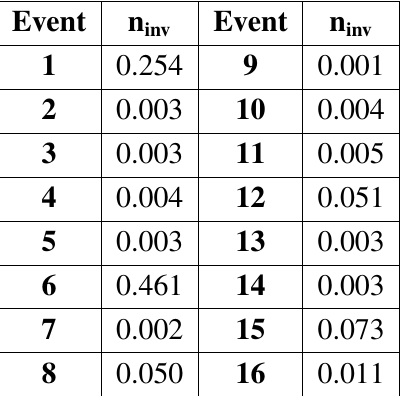
Table 2. Number of invalid radar records divided by the total number of records for each event ( n inv